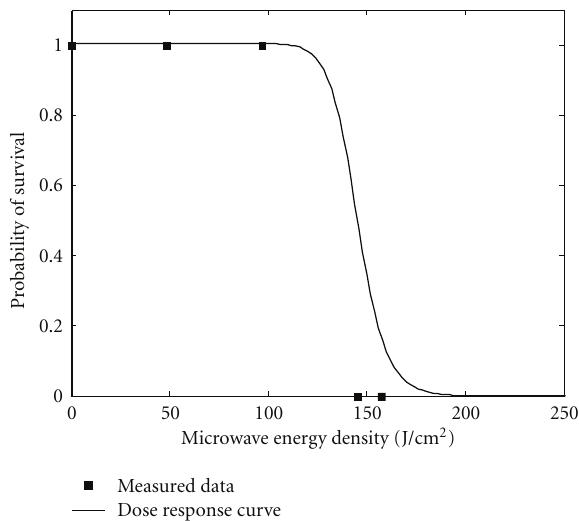
Figure 11: Microwave energy density dose response curve forpaddy melon